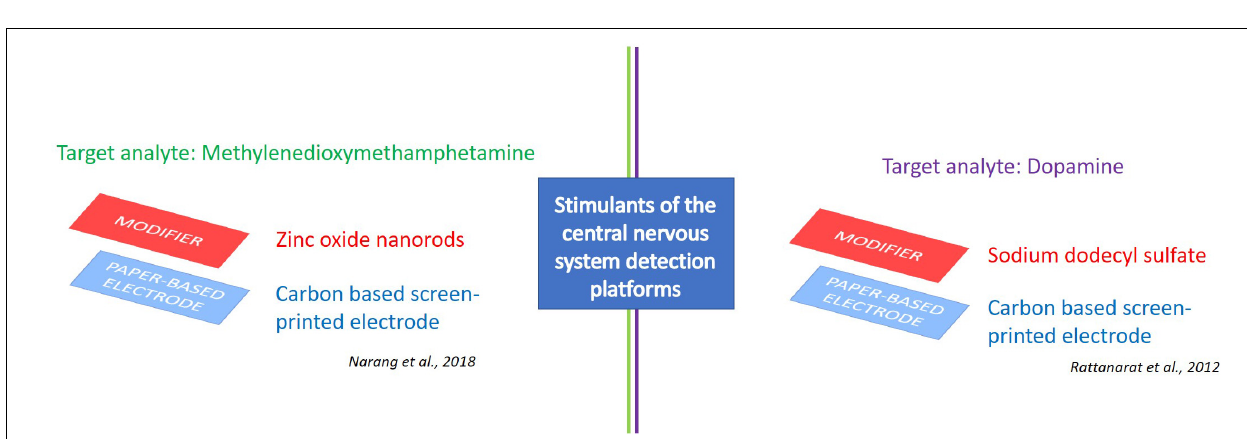
FIGURE 5 | e-PAD platforms for detection of stimulants of the central nervous system. Target analytes: Methylenedioxymethamphetamine (Narang et al., 2018), and dopamine (Rattanarat et al., 2012).